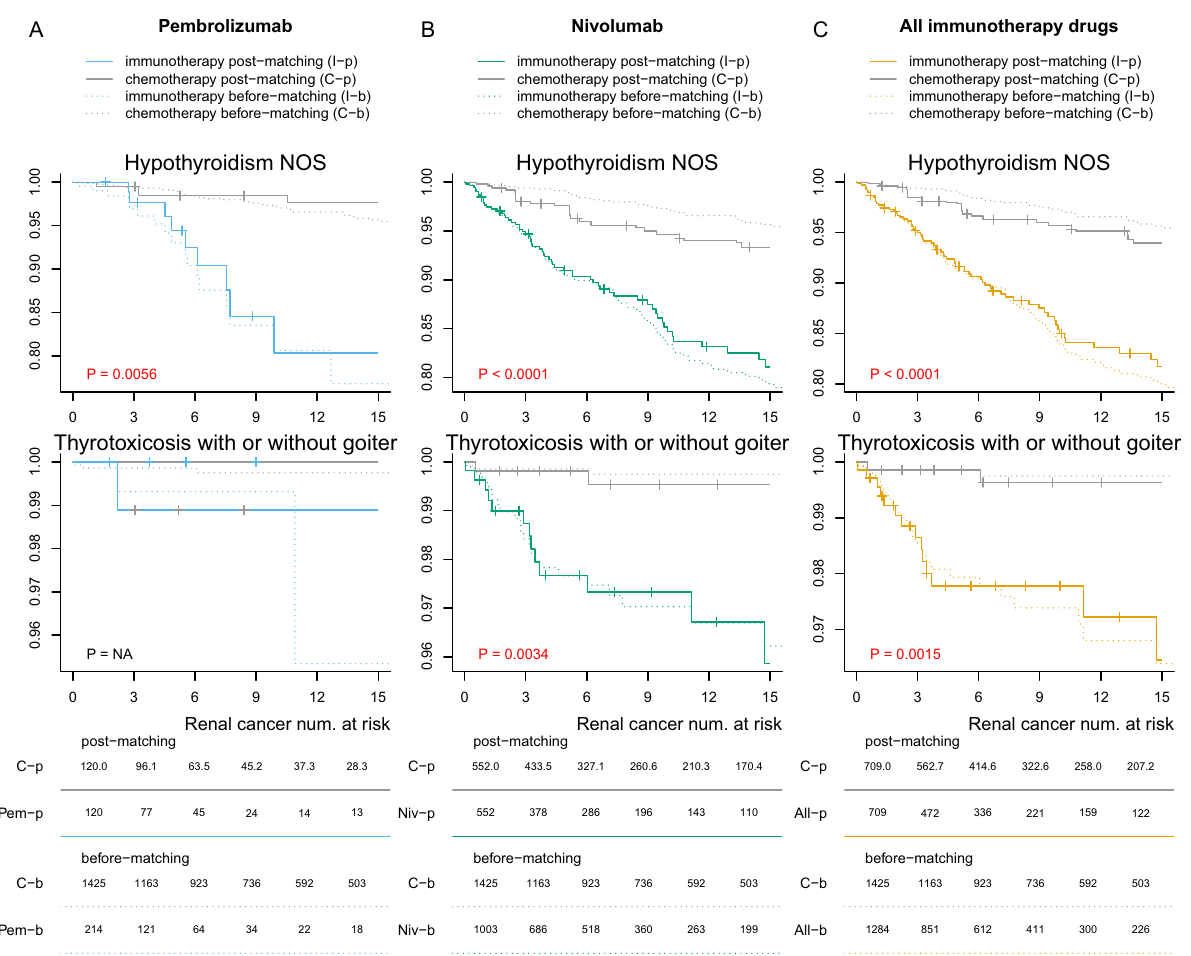
Fig. 4 Time-to-event plot showing the time between treatment initiation and the development of speci fi c irAEs. The comparisons between renal cancer patients receiving chemotherapy with A pembrolizumab, B nivolumab, and C all immune checkpoint inhibitors are shown in three separate columns. We examined 56 irAEs separately, with p -values corrected by the Benjamini – Hochberg procedure. Adjusted p -values < 0.05 were highlighted in red. Renal cancer patients receiving nivolumab have higher risks of developing hypothyroidism and thyrotoxicosis, but those receiving pembrolizumab did not have a signi fi cantly increased risk. Each tick represents 50 censored patients. The curves are truncated in the 15th month after treatment initiation for better visualization. The numbers at the bottom panel indicate the number of remaining patients at 0, 3, 6, 9, 12, and 15 months after treatment initiation. Plots for all other cancer types can be found in Supplementary Fig. 2; plots for a longer time horizon can be found in Supplementary Fig.